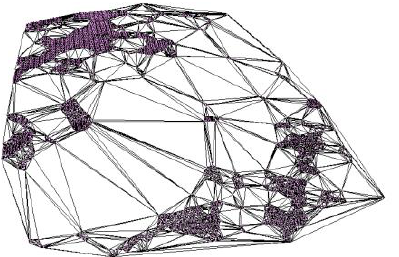
Figure 6. Initial Triangulation of Classified Ground Points – Zone 3 (Pre - Progressive TIN